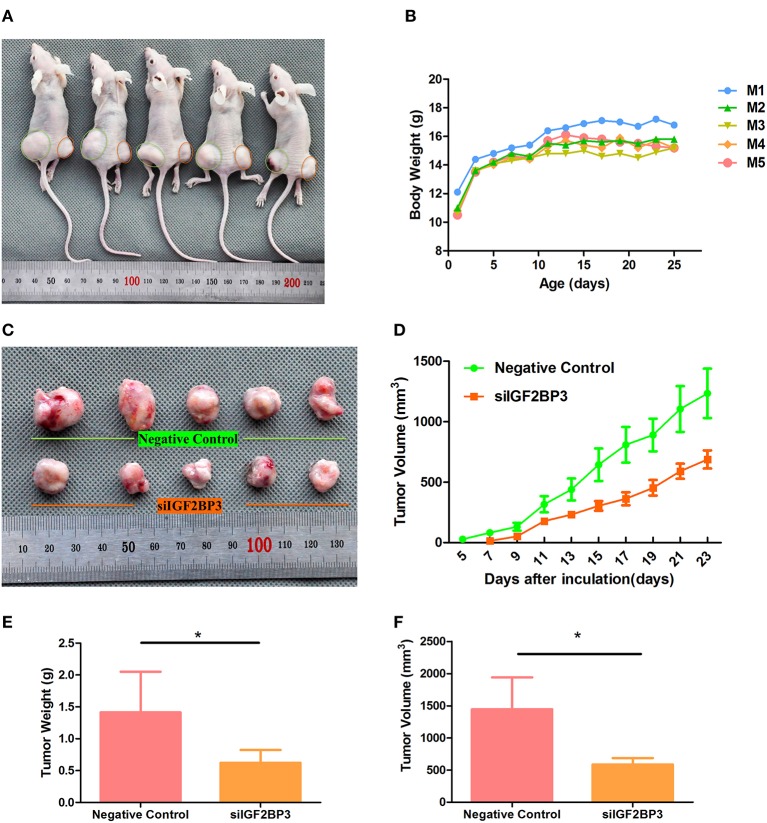
Tumor growth suppression in vivo by siIGF2BP3. (A) The subcutaneous xenograft tumor models were generated by transplanting human ovarian cancer ES-2 cells into nude mice. (B) Body weight changes over the 25 days of tumor growth. (C) Tumor growth at day 25 by NC and siIGF2BP3-1 treatments. (D) Tumor volume changes over the 25 days of tumor growth. (E) The removed tumors were weighed and statistically analyzed (n = 5). The data represent the means ± SD. *P < 0.05, vs. NC. (F) Tumor volume comparison among the animals of the two groups at day 25. The data represent the means ± SD. *P < 0.05, vs. NC.